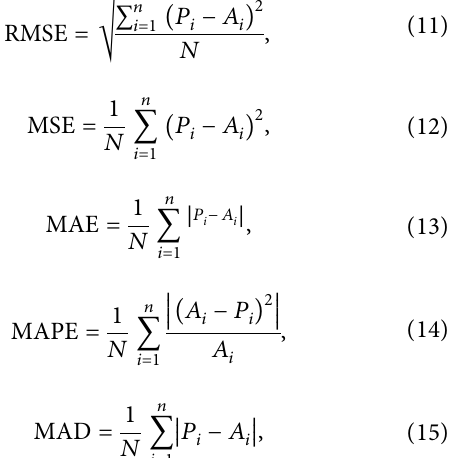
Figure 1(a), vehicle accidents had an overall upward